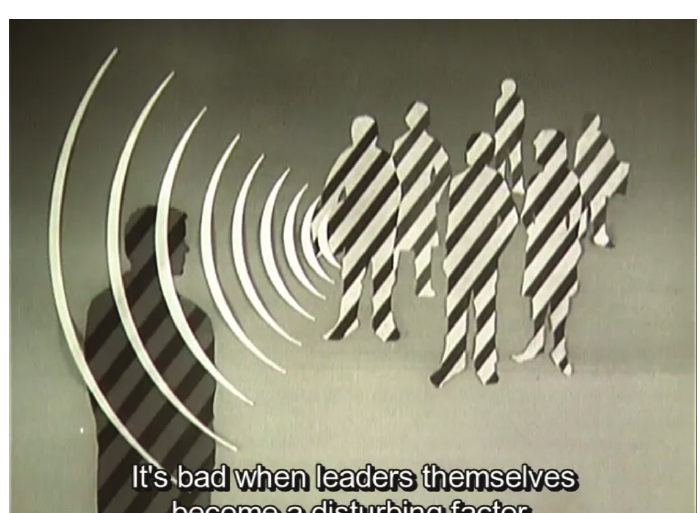
Video 2. ‘Arbeitskollektiv’ [Work Collective], Wegweiser Gesundheit , DFF, 1975 (©DHMD).